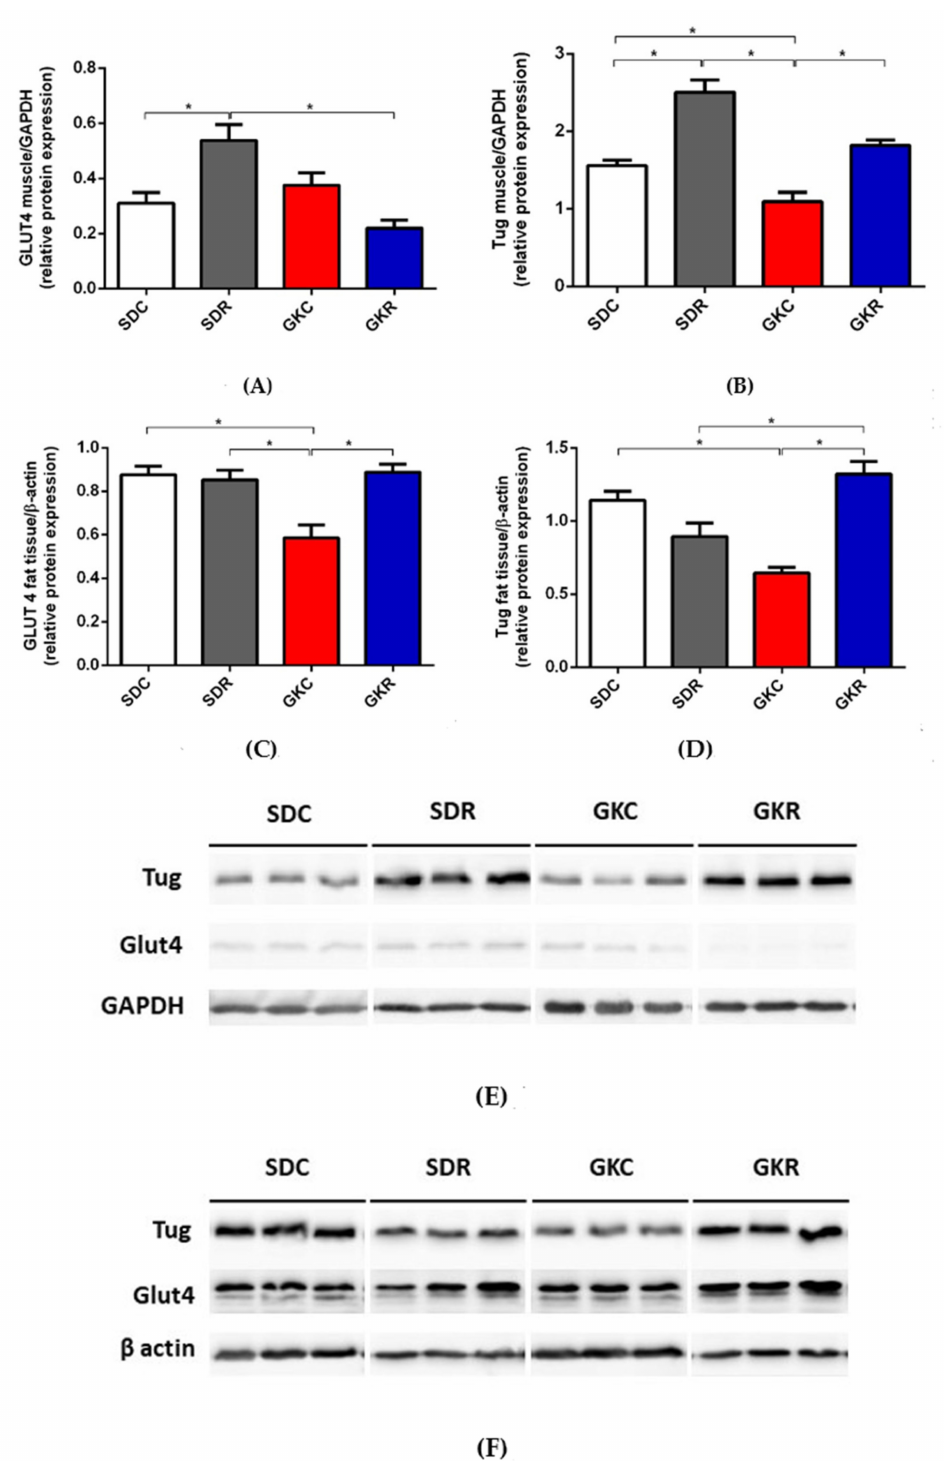
Figure 4. Effects of resveratrol on the expression of GLUT4 and TUG in the skeletal muscle and fat tissue of SD and GK rats. The skeletal muscle GLUT4 ( A ) and TUG ( B ), fat tissue GLUT4 ( C ), and TUG ( D ). Western blot immunodetection with antibodies to the indicated proteins, GAPDH or β -actin expression used as a loading control. Protein levels relative to GAPDH or β -actin quantified by densitometry. Results are representative of at least two independent experiments. The skeletal muscle ( E ) and fat tissue ( F ). SDC—Sprague-Dawley control rats, SDR—Sprague-Dawley rats treated with resveratrol, GKC—Goto-Kakizaki control rats, GKR—Goto-Kakizaki rats treated with resveratrol. Results represent the means ± SEM from 10 rats. *—Differences statistically significant ( p <